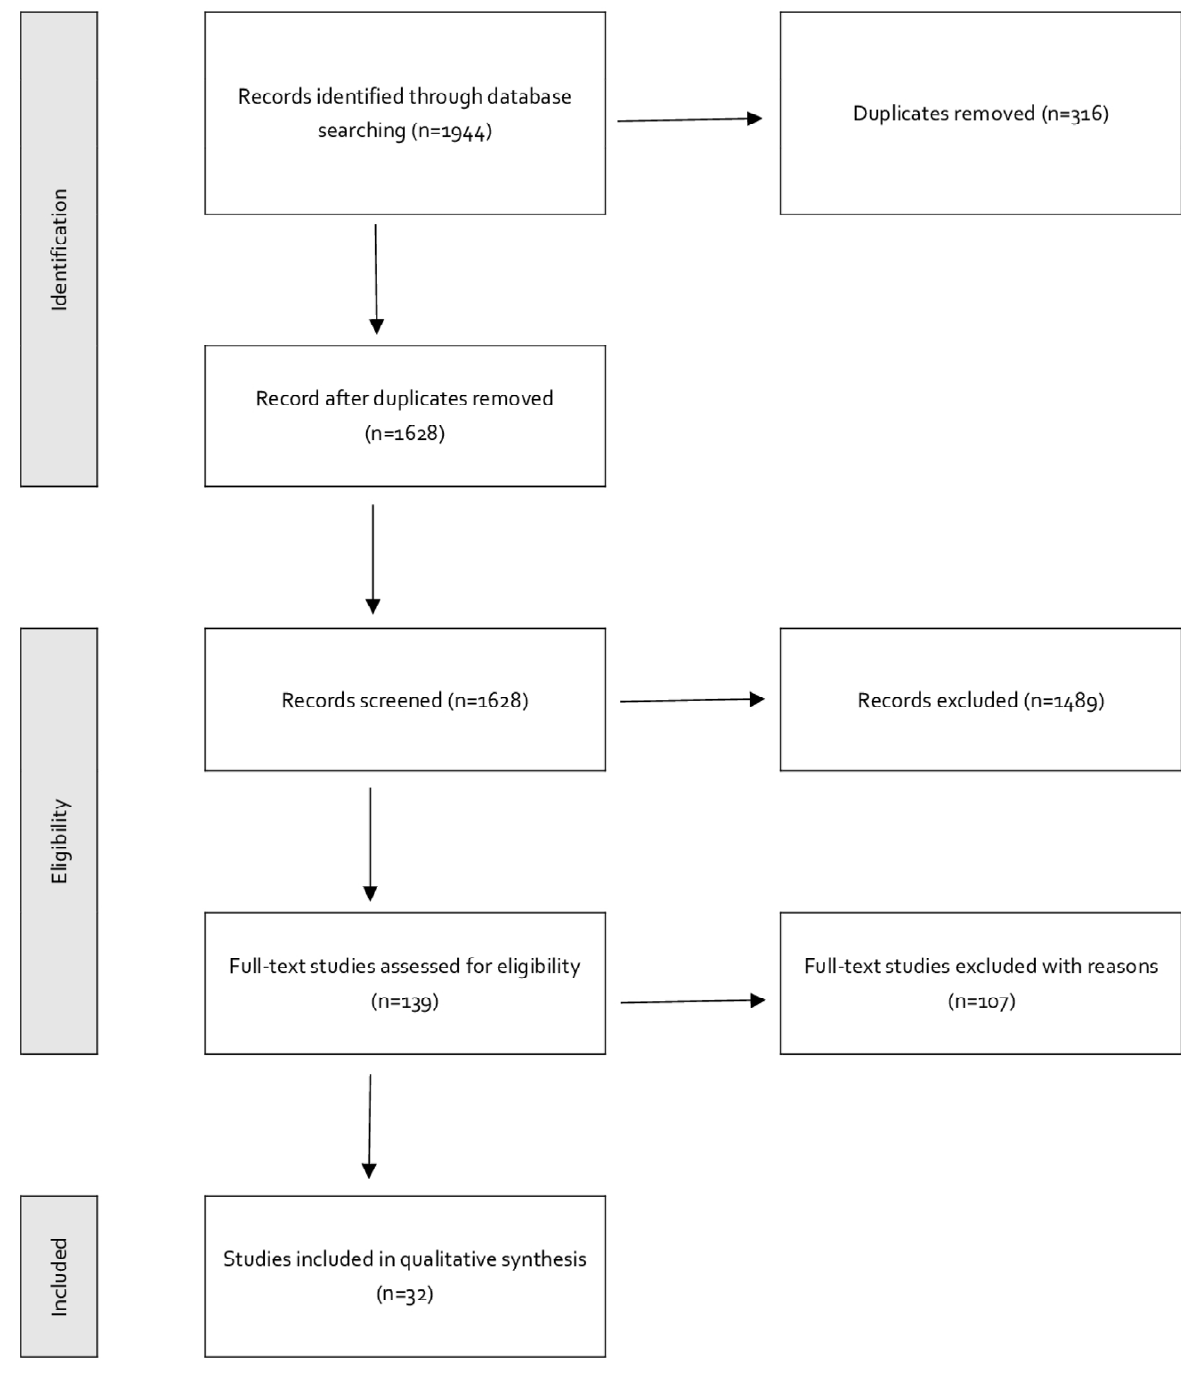
Figure 1. The PRISMA